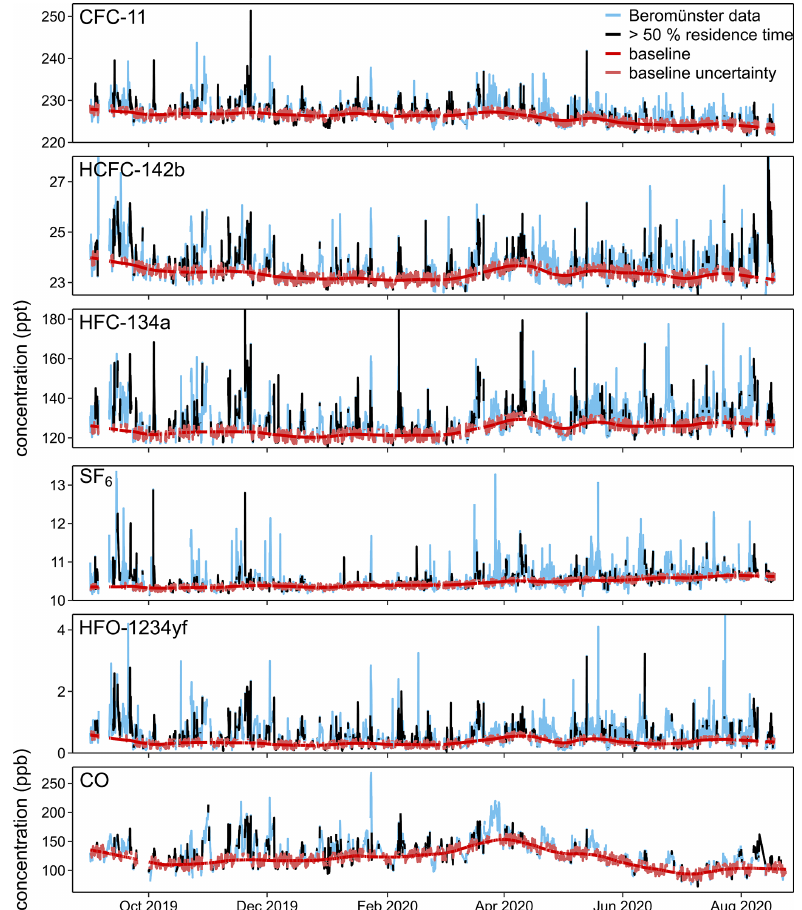
Figure 3. The 1-year time series of the atmospheric concentrations measured at Beromünster. Air samples with more than 50% relative residence time in Switzerland are highlighted in black. The baselines (red lines) calculated with a REBS bandwidth parameter of 30d are shown with their uncertainty bands (light red) derived with the REBS multiplication factor set to